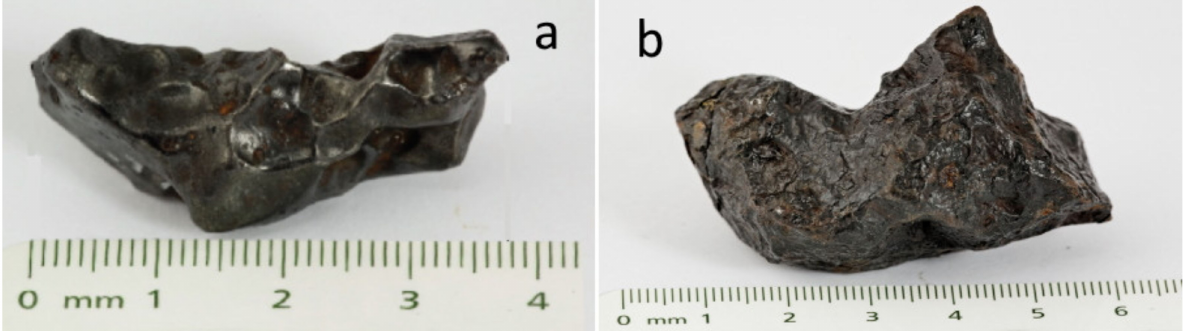
Figure 1. The studied iron meteorites: ( a ) Find 1 and ( b ) Campo del Cielo. The NWA 1990 stony meteorite fragments have a dark crust but, after crushing, the powders reveal a brown-reddish color. Figure 2 shows typical images. After micro- scopic investigations, chondrules appear to be absent, so it was grouped in achondrites stony